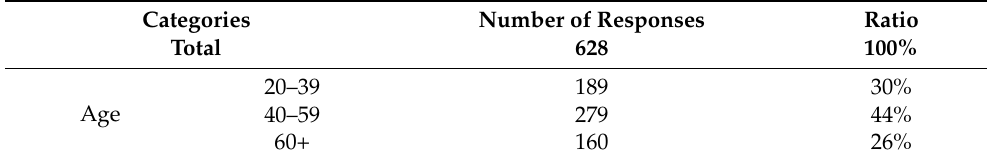
Table 4. Characteristics of